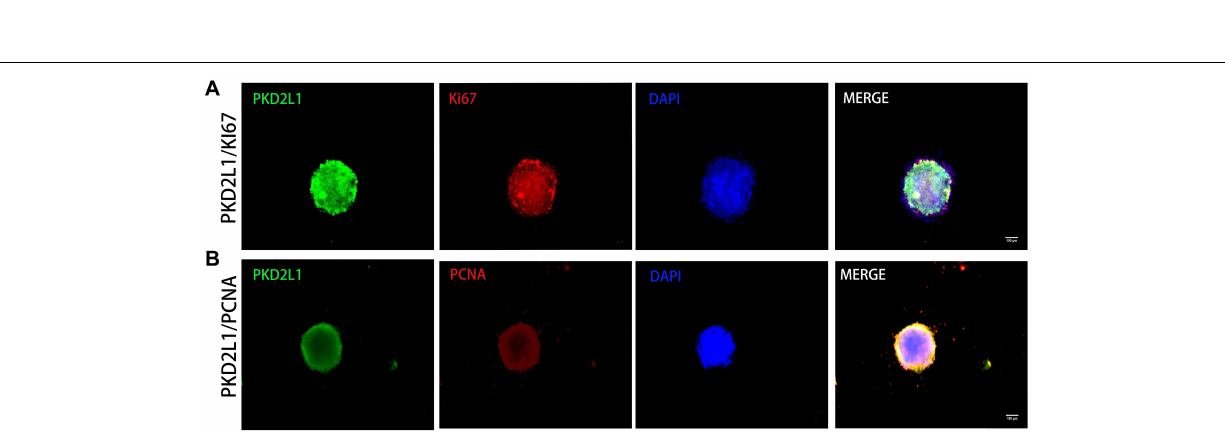
Frontiers in Cellular Neuroscience |